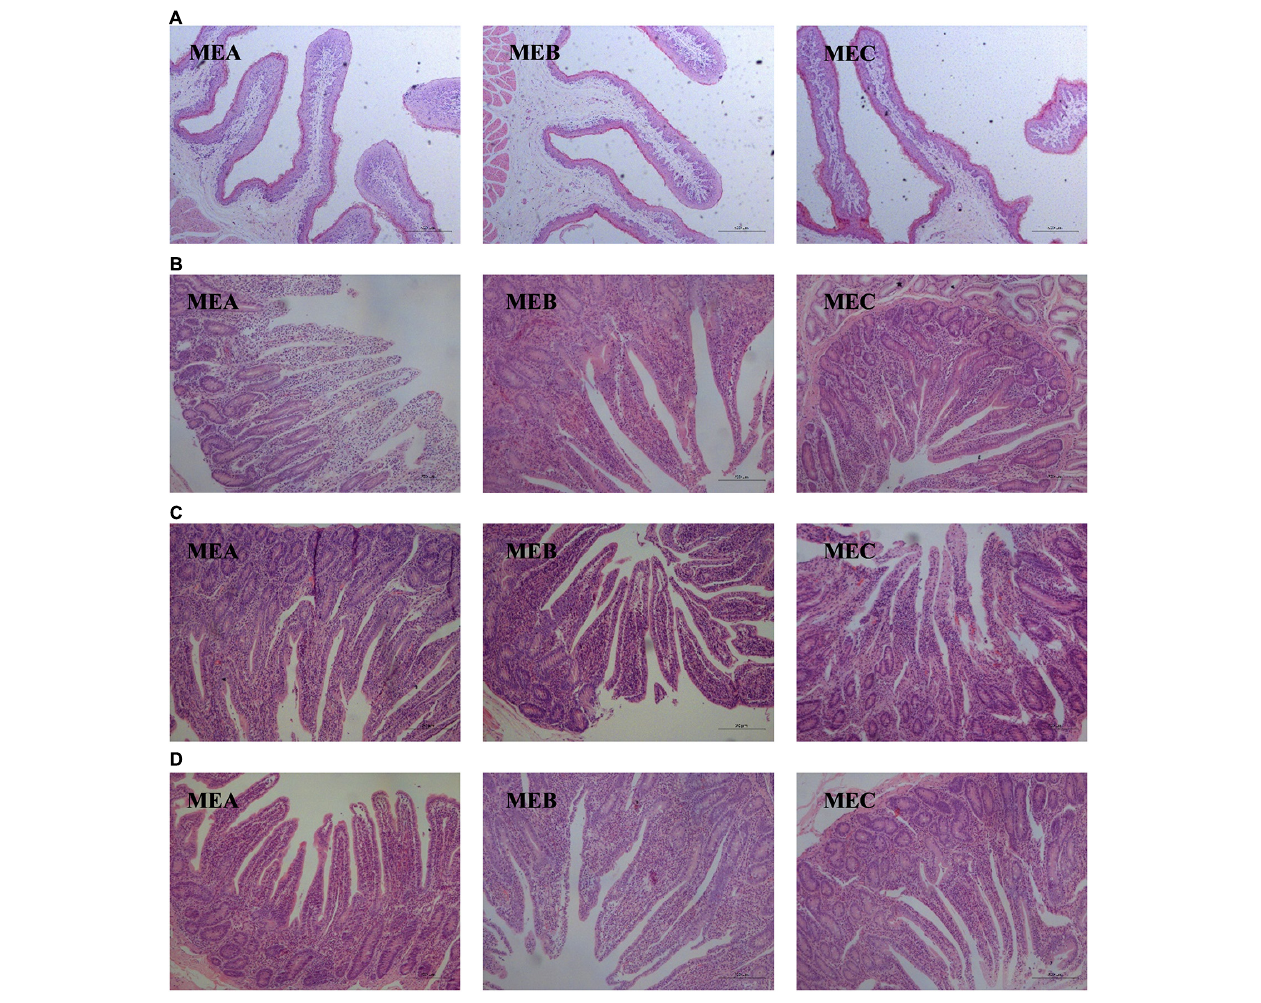
FIGURE 1 | Effects of low-, medium-, and high-energy diets on rumen and small intestinal morphology of male Hu lambs. (A) Papillary height of rumen. Scale bar, 500 µ m. (B) Duodenum. Scale bar, 200 µ m. (C) Jejunum. Scale bar, 20 µ m. (D) Ileum. Scale bar, 200 µ m.